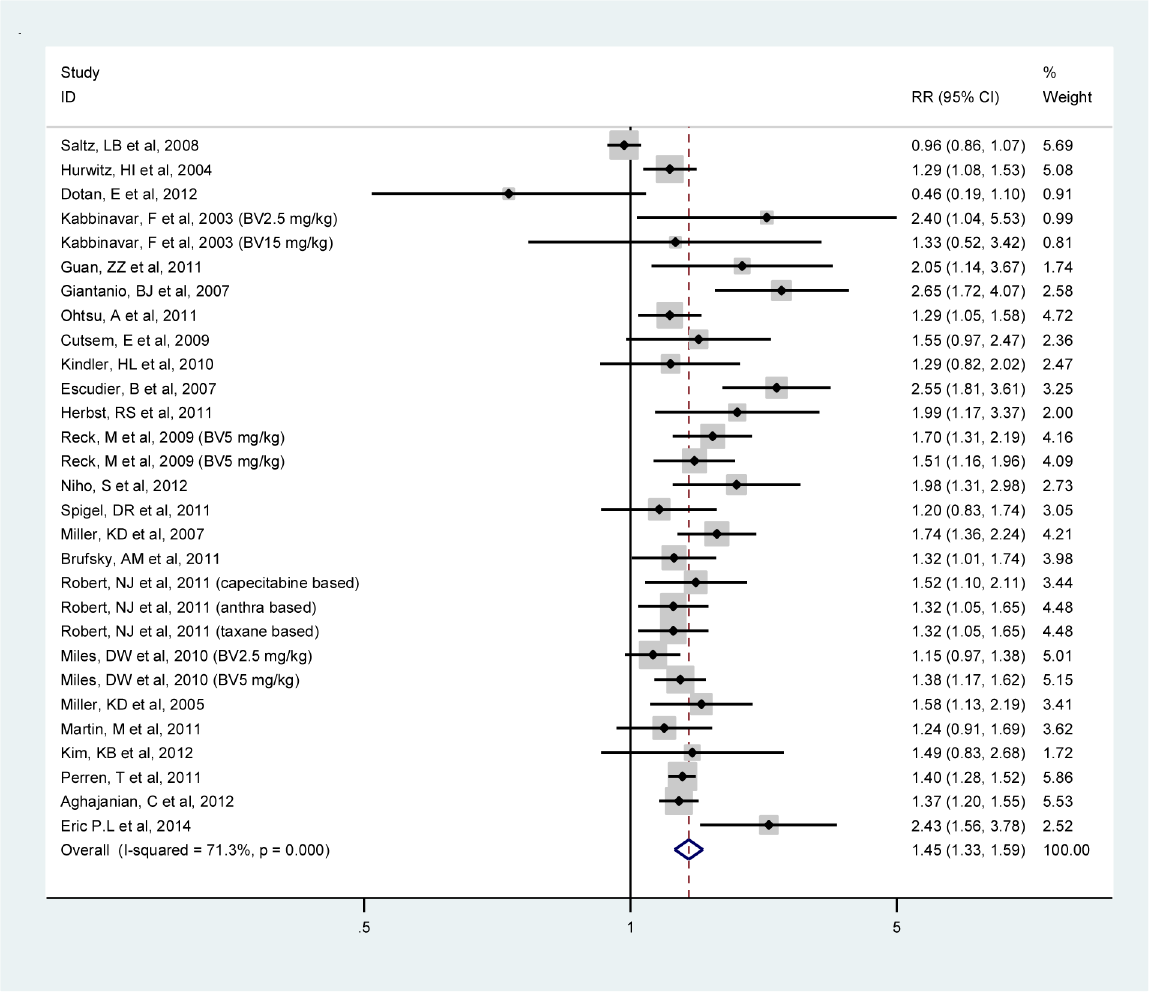
Fig 4. Meta-analysis of the risk ratios of overall response rate comparing bevacizumab and standard therapy in all trials combined.